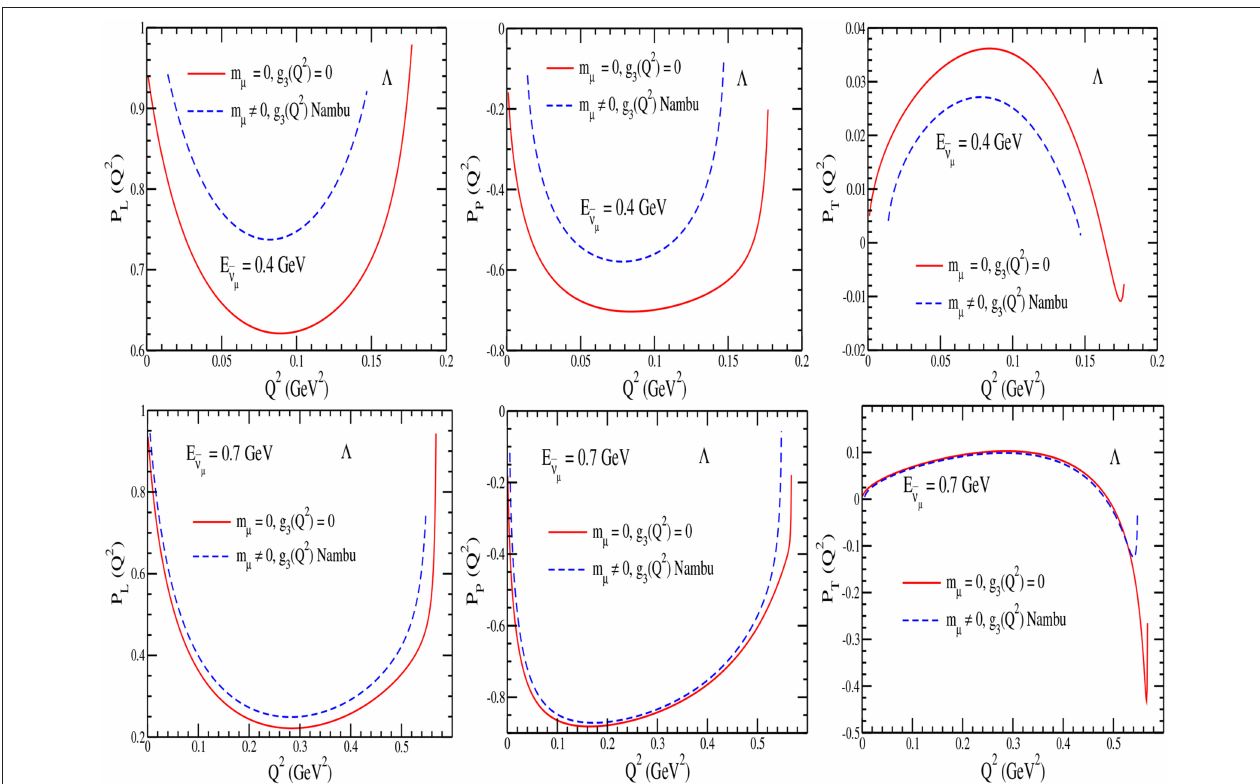
p ν µ µ + 3 at E ν µ = 0.4 GeV (upper) and 0.7 GeV (lower) with ¯ + → + ¯